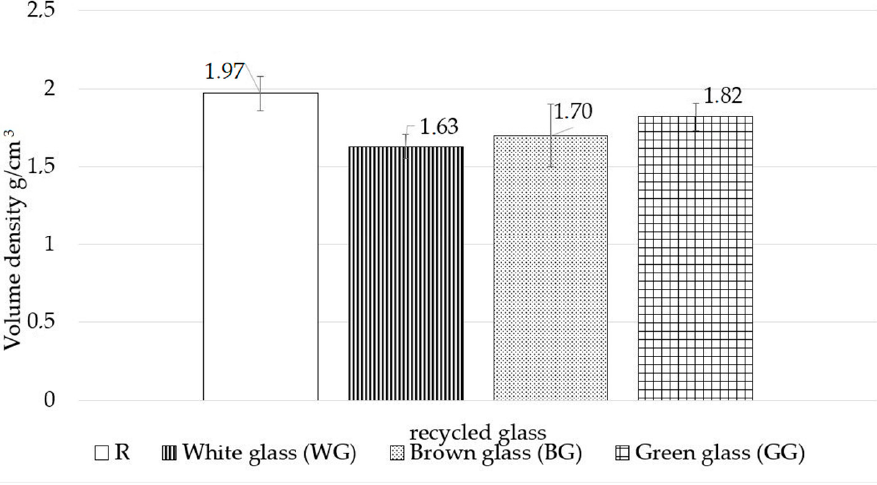
Figure 6. Volume density results.